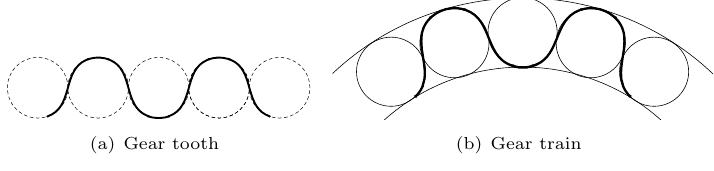
Figure 11. Gear design using S-shaped transition curve.